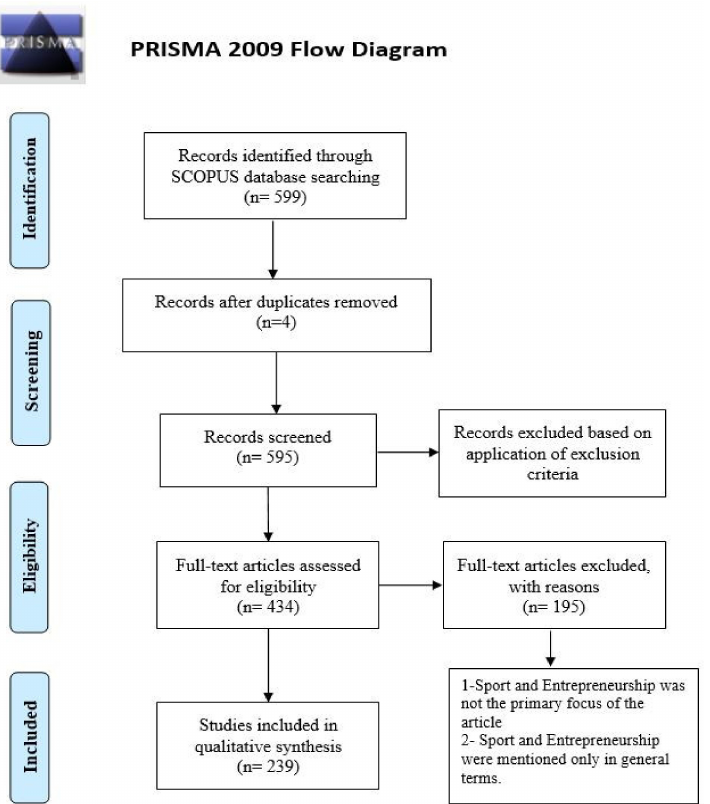
Figure 1. Flow diagram—PRISMA, 2009.